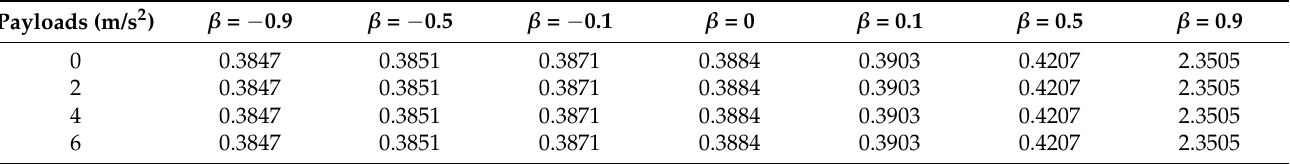
Table 7. Root mean squared value of the control signal u 4 in the first 30 s under different payloads and different fractional orders in the proposed